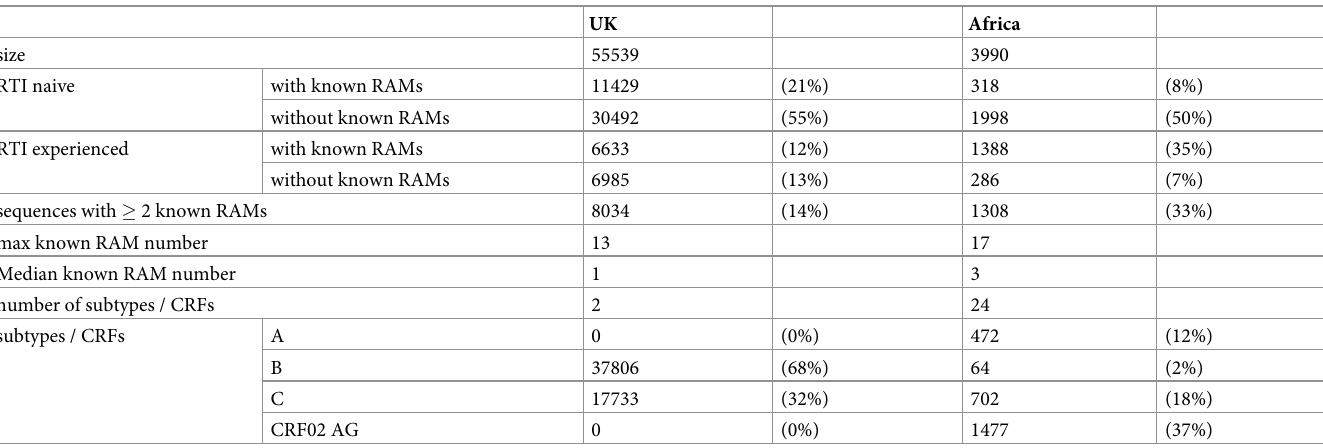
Table 1. Summary of the UK and African datasets.